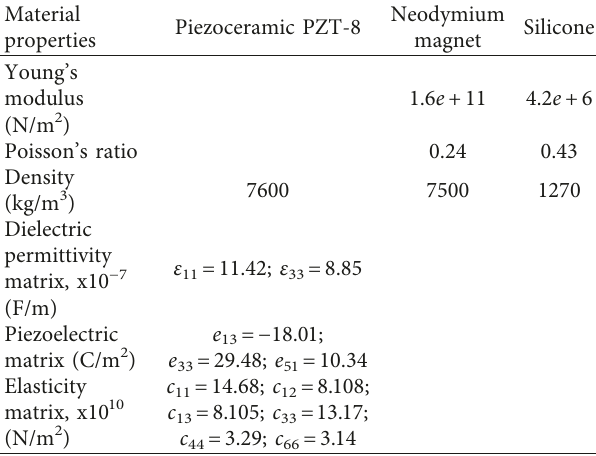
Table 1: Properties of the materials used for